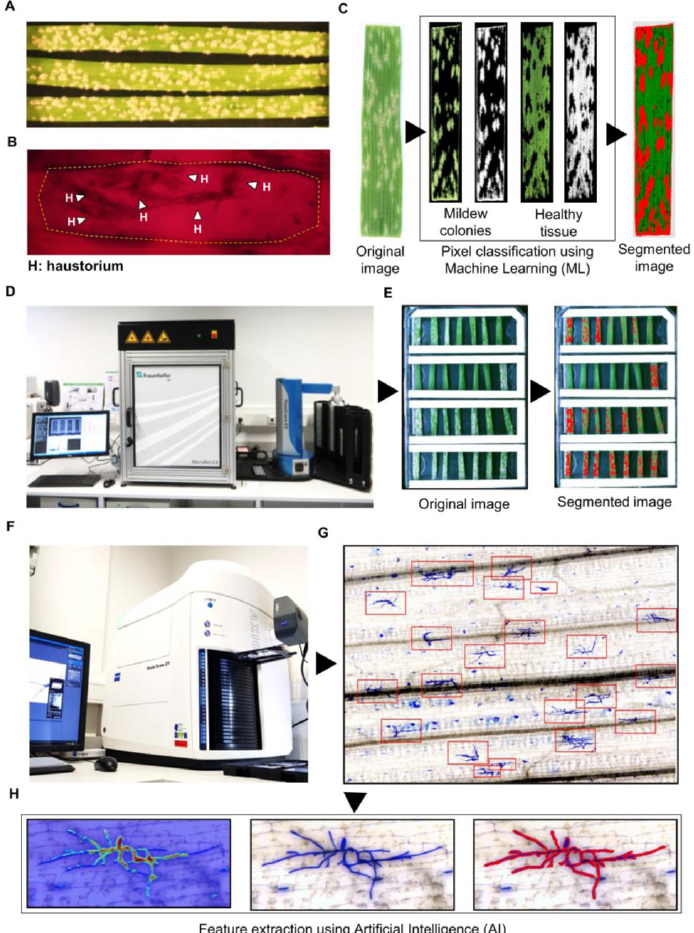
Figure 1. Next-generation machine-learning (ML)-and artificial-intelligence (AI)-aided phenomics for precision breeding of powdery mildew resistance in wheat. (Photos A to C supplied by Salim Bourras and D to H by Dimitar Douchkov). ( A ) Macroscopic “powdery mildew” colonies from the genome reference isolate Bgt _96224 growing on the susceptible hexaploid wheat cv Chinese Spring. ( B ) Multiple mildew intracellular haustorial feeding structures colonizing a wheat